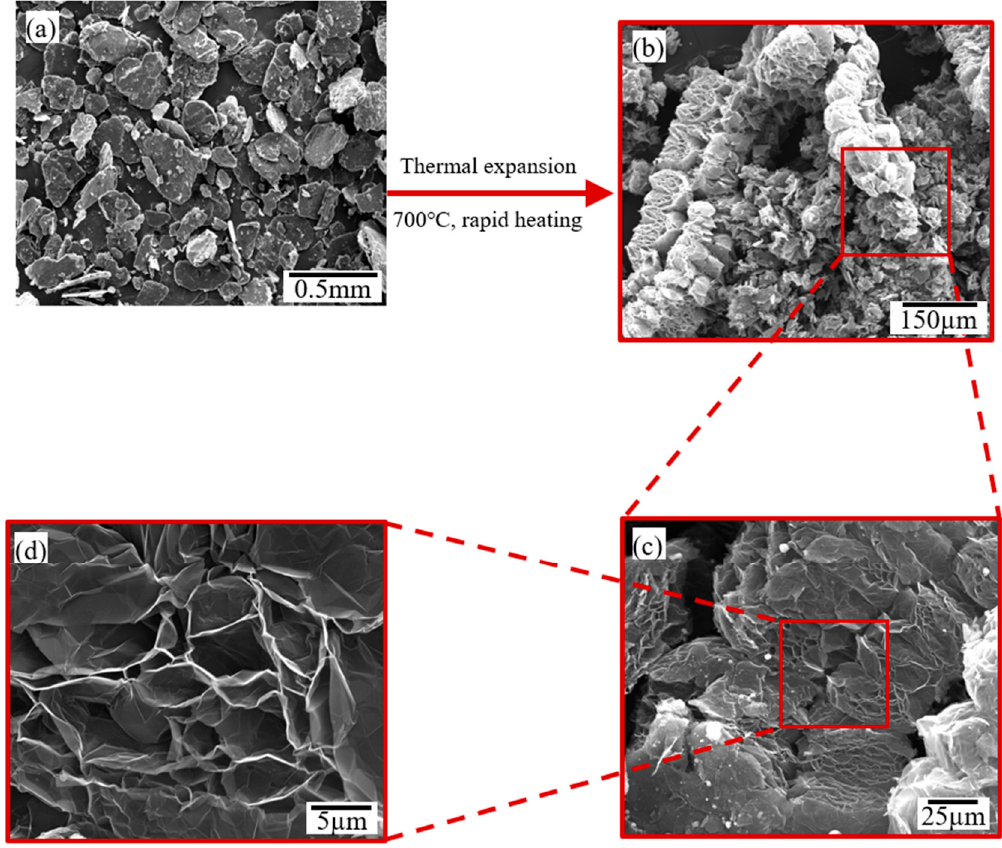
Figure 4. SEM images of ( a ) graphite intercalated compounds (GICs) and ( b – d ) low to high magnification images for expanded GICs after thermal shock at 700 °C for one min.